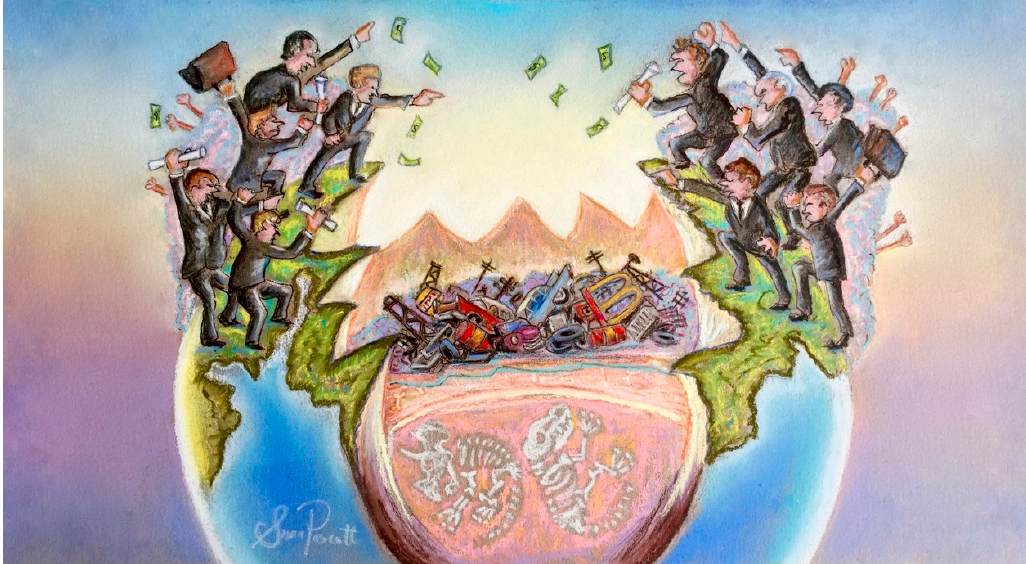
Figure 1. Anthropocene Syndrome: a complex of environmental degradation, biological annihilation in the form of species losses, non-communicable disease epidemics, climate change, and increasing incivility in public and professional discourse. The symbiocene can transcend these trends. The health of people, place, and planet requires compassion, education by example, civility, and diversity of thought. Image with permission: Susan L. Prescott.